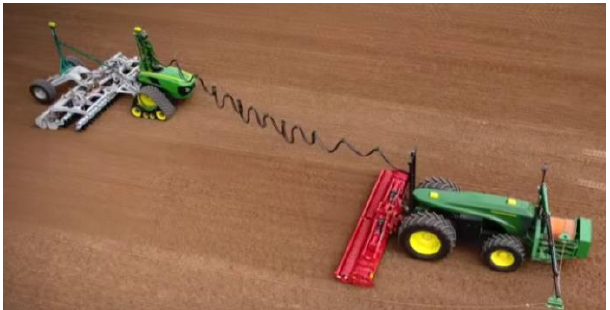
Fig. 33. John Deere GridCON and John Deere Joker [47]